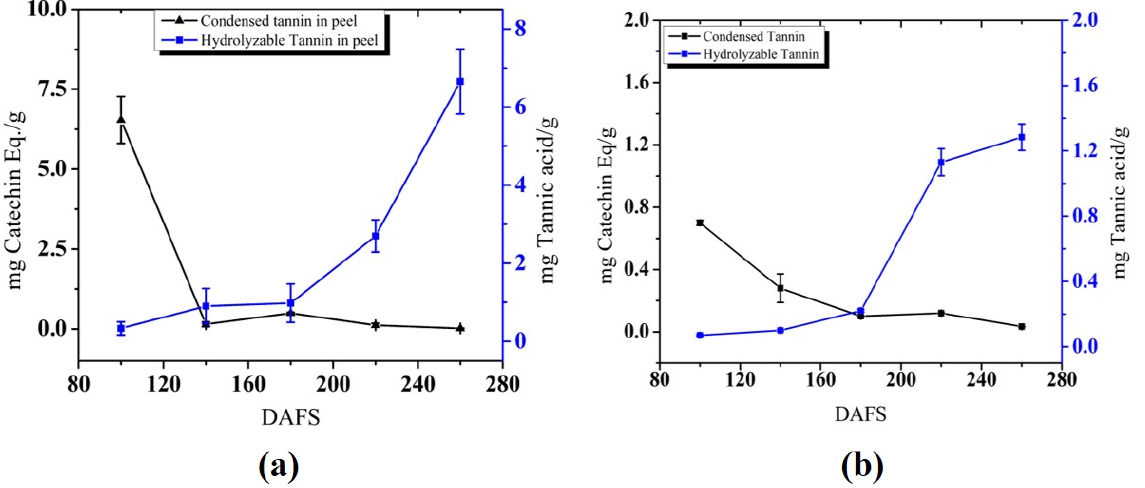
Figure 6. Tannin content in peel in ( a ) 2018; and ( b ) 2019 . DAFS; days after fruit set.